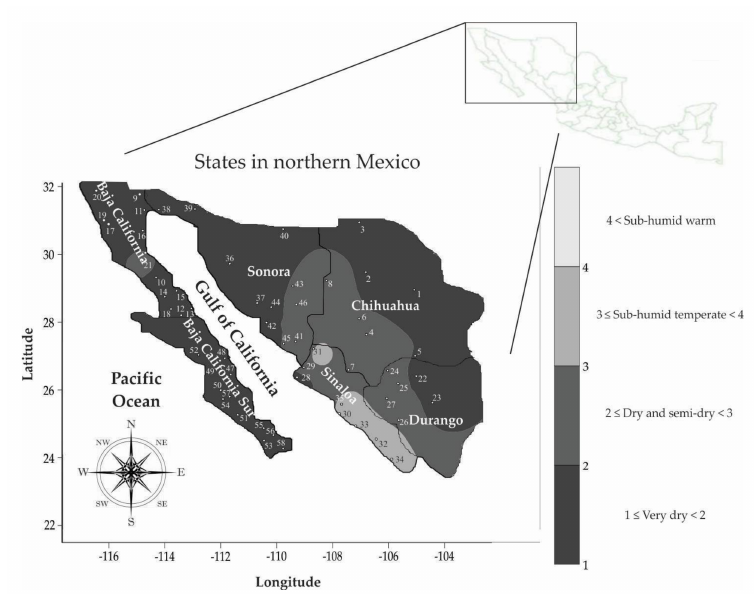
Figure 1. Location, climate classification and weather stations in six states in northern Mexico (Chihuahua, Baja California, Durango, Sinaloa, Sonora and Baja California Sur). Source: Authors, following the Climate Computing (CLICOM, 2018) database and climatic classification of INEGI (2018) (http://www.cuentame.inegi.org.mx/monografias/).